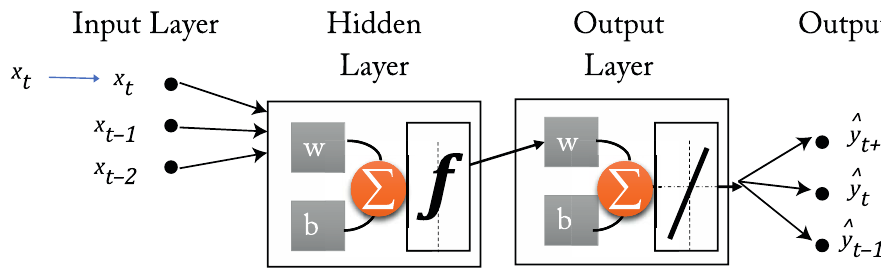
Figure 6. Function fitting neural network schema.